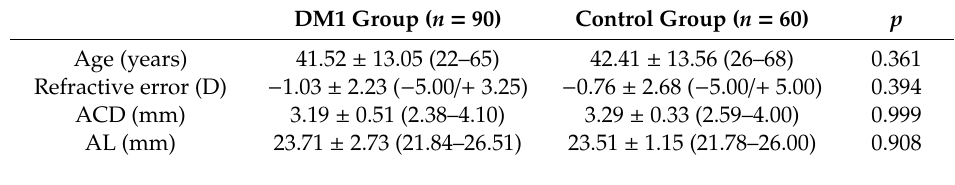
Table 1. Mean, standard deviation (SD) and range (minimum-maximum) of demographics and ocular characteristics of the type 1 diabetes Mellitus (DM1) and control groups. No significant di ff erences ( p < 0.05) were found between groups in any of the parameters